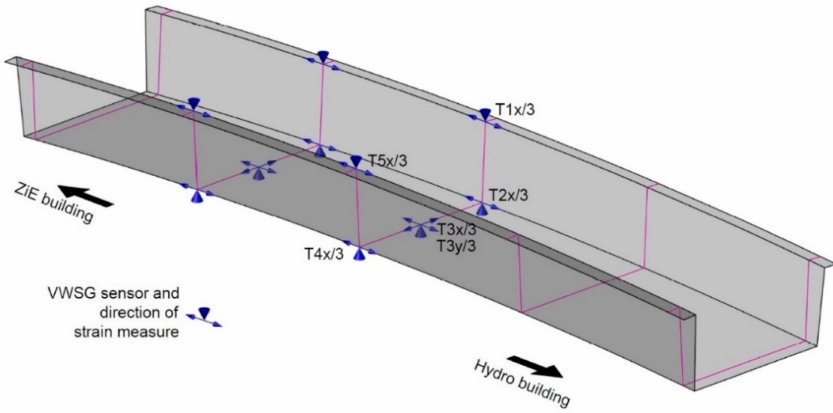
Figure 6. Location of VWSG